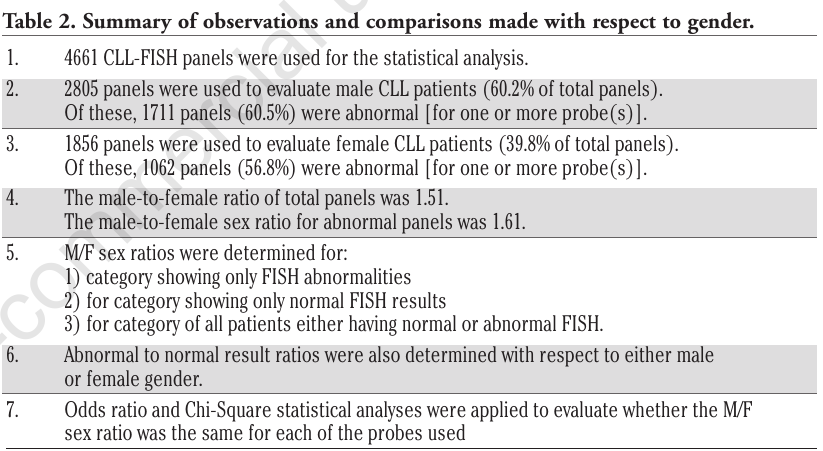
Table 2. Summary of observations and comparisons made with respect to gender.